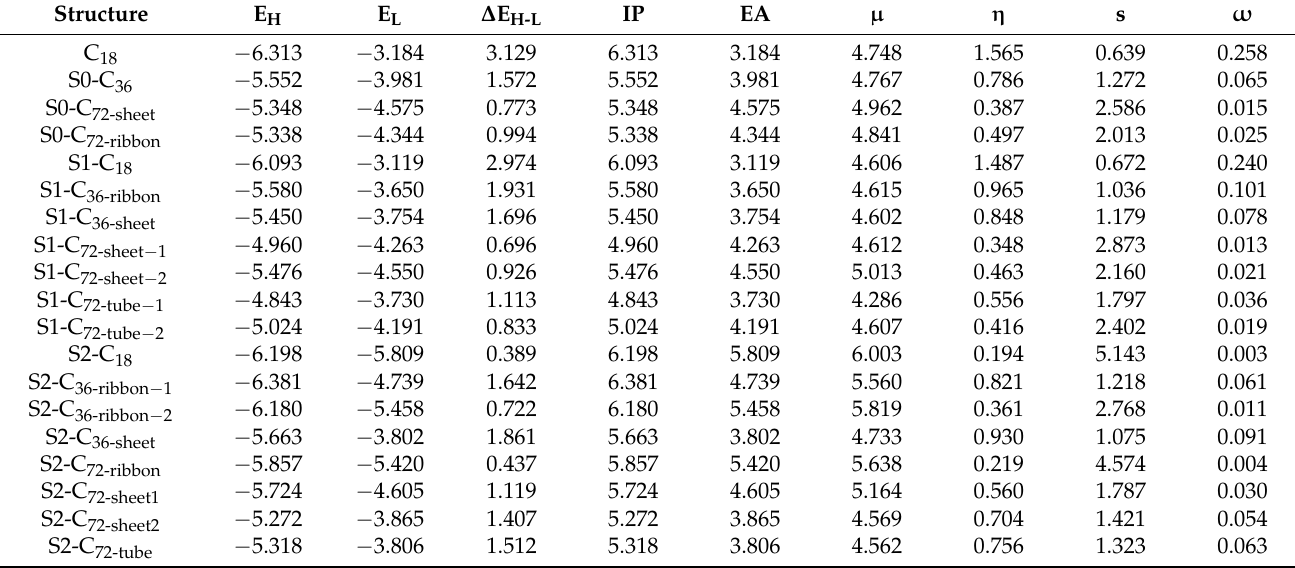
Table 1. The HOMO and LUMO energies and related quantities (all values in